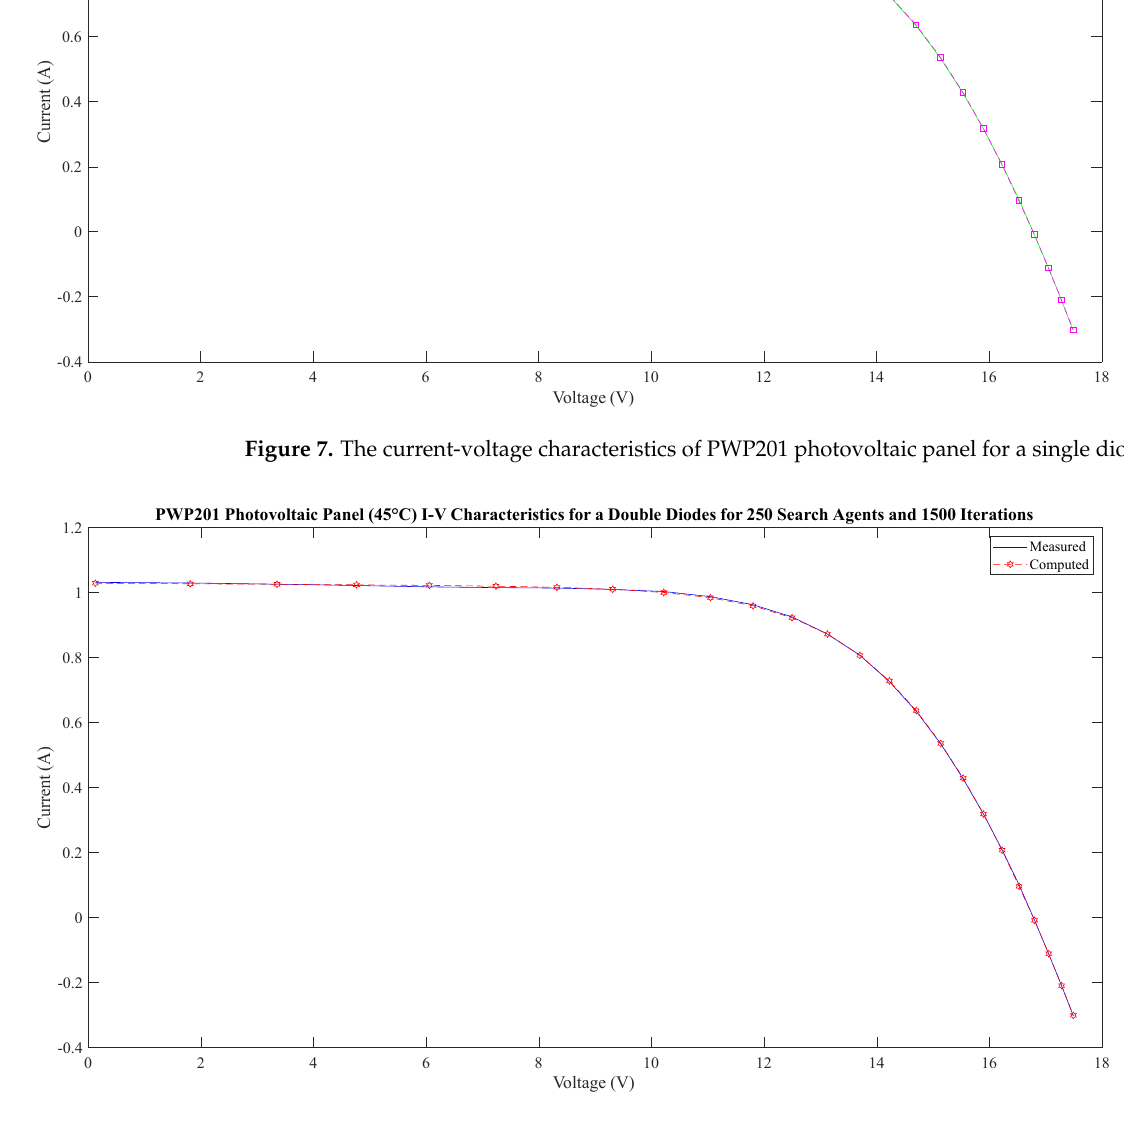
Figure 8. The current-voltage characteristics of PWP201 photovoltaic panel for double diodes (DDM).